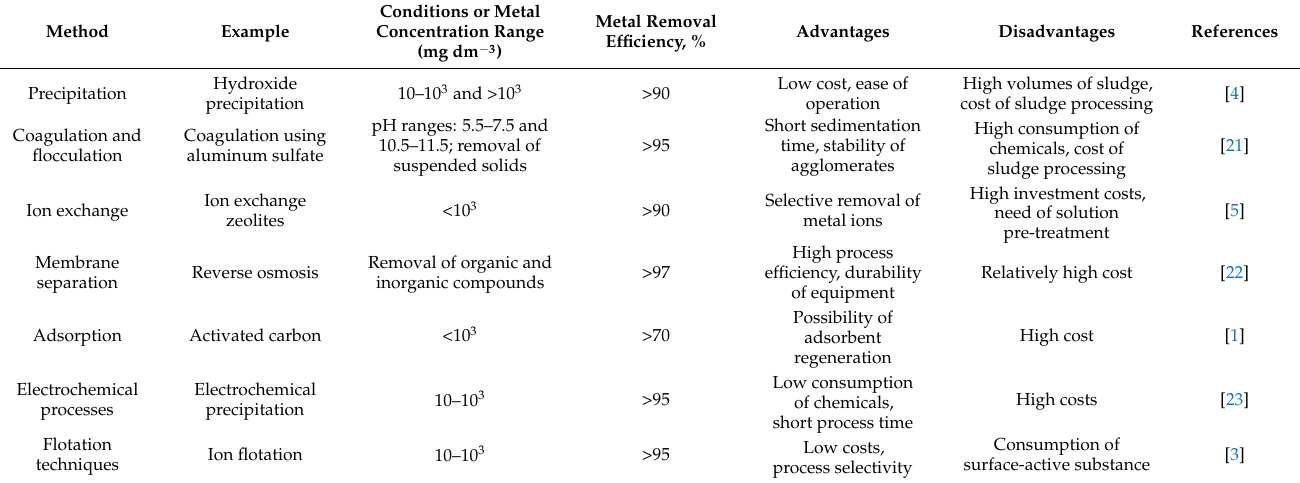
Table 1. Physicochemical methods for removal of various metal ions from